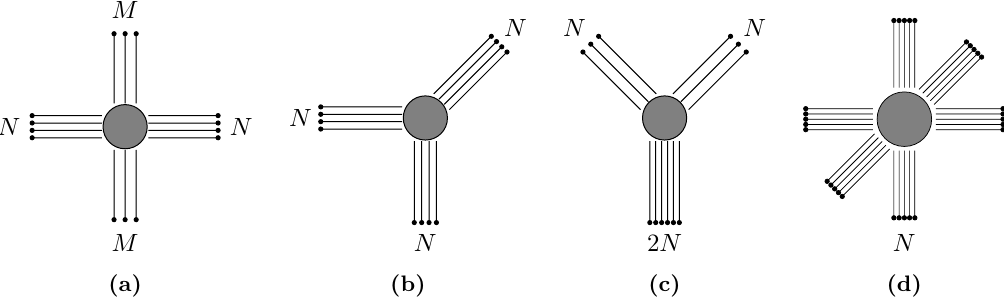
Figure 2 . 5-brane junctions for the + N;M , T N , Y N and (cid:0) + N theories from left to right. ( p; q ) 5-branes are represented by straight lines at angles determined by the p; q charges, the (cid:12)lled black dots represent corresponding [ p; q ] 7-branes. The 5d SCFTs are realized by intersections at a point; the external 5-branes have been resolved slightly to visually represent the involved